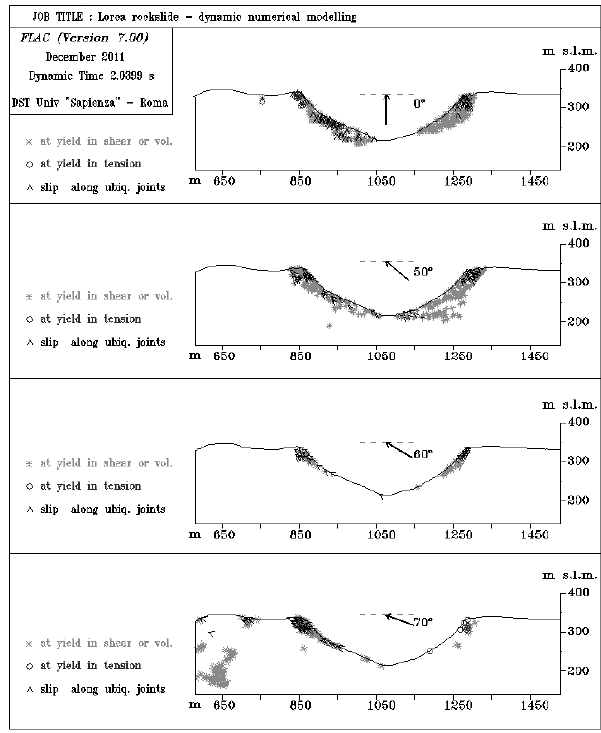
Fig. 10. Plasticity conditions resulting from the FLAC dynamic nu- merical modeling using seismic wave propagation at various inci- dence